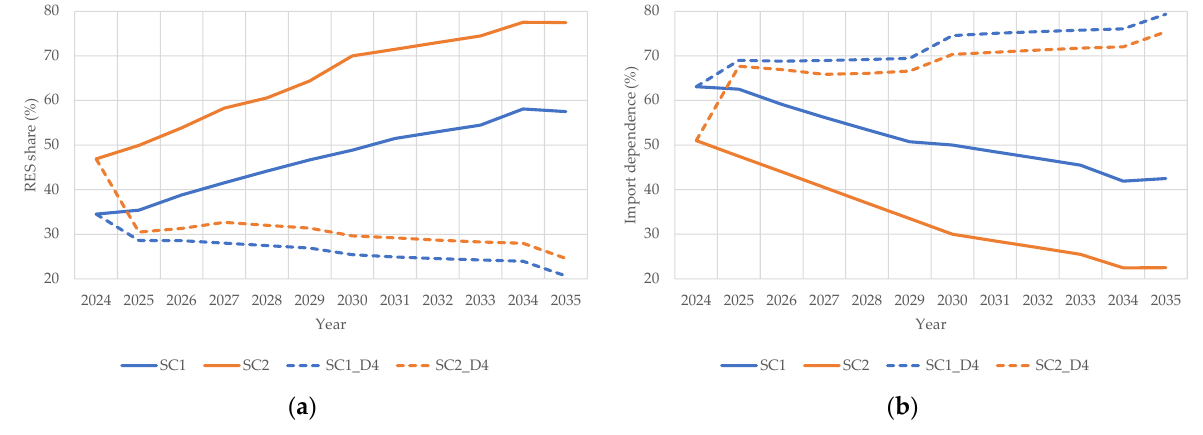
Figure 11. Resilience indicators in the case of the loss of wind generators: ( a ) RES share; ( b ) import dependence.